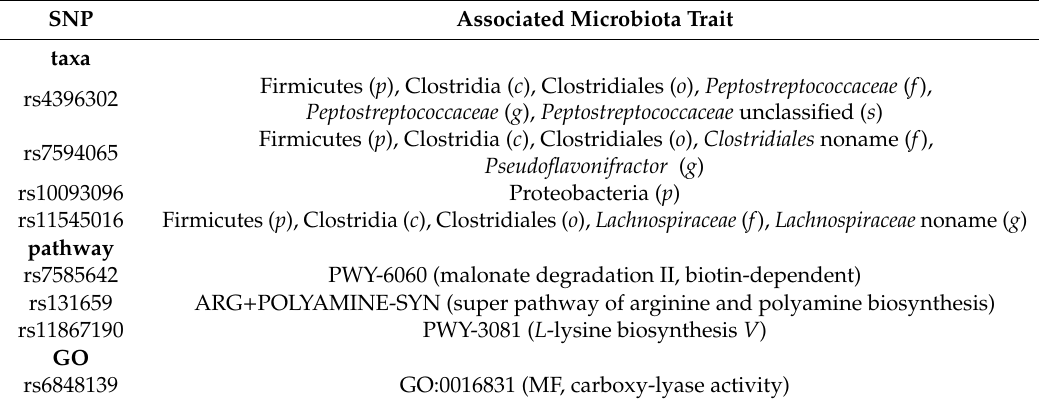
Table 2. Associated microbiota traits of 2SMR